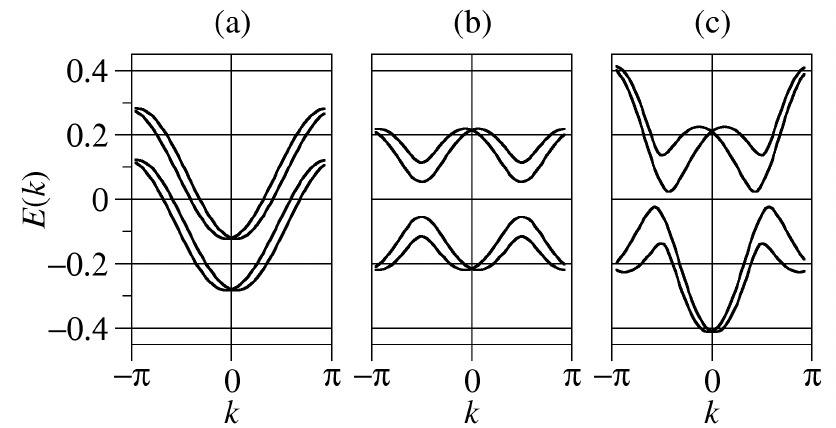
Figure 1. Energy dispersion relation of the helical system for α c = − 0.08 and θ = π /6 in ( a ) the symmetric configuration with parameters t A = t B = 0.1 and λ A = λ B = 0.01, ( b ) the quasi-symmetric configuration with parameters t A = − t B = 0.1 and λ A = λ B = 0.01, and ( c ) the asymmetric configuration with parameters t A = − 2 t B = 0.2 and 2 λ A = λ B =